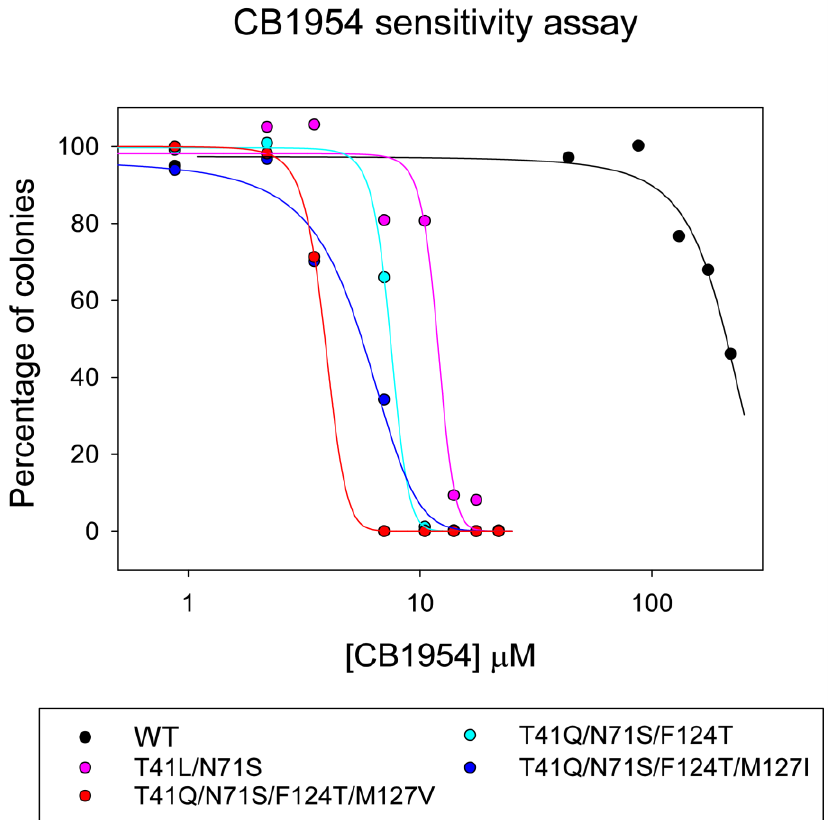
Figure 5. Survival at different concentrations of CB1954 of lysogens expressing either wild-type or mutant NfsB . Black circles — wild type protein, magenta circles — T41L/N71S NfsB, cyan circles — T41Q/N71S/F124T; blue circles — T41Q/N71S/F124T/M127I; red circles — T41Q/N71S/F124T/M127V. Lines show the fits to a sigmoidal curve (Equation (3)).